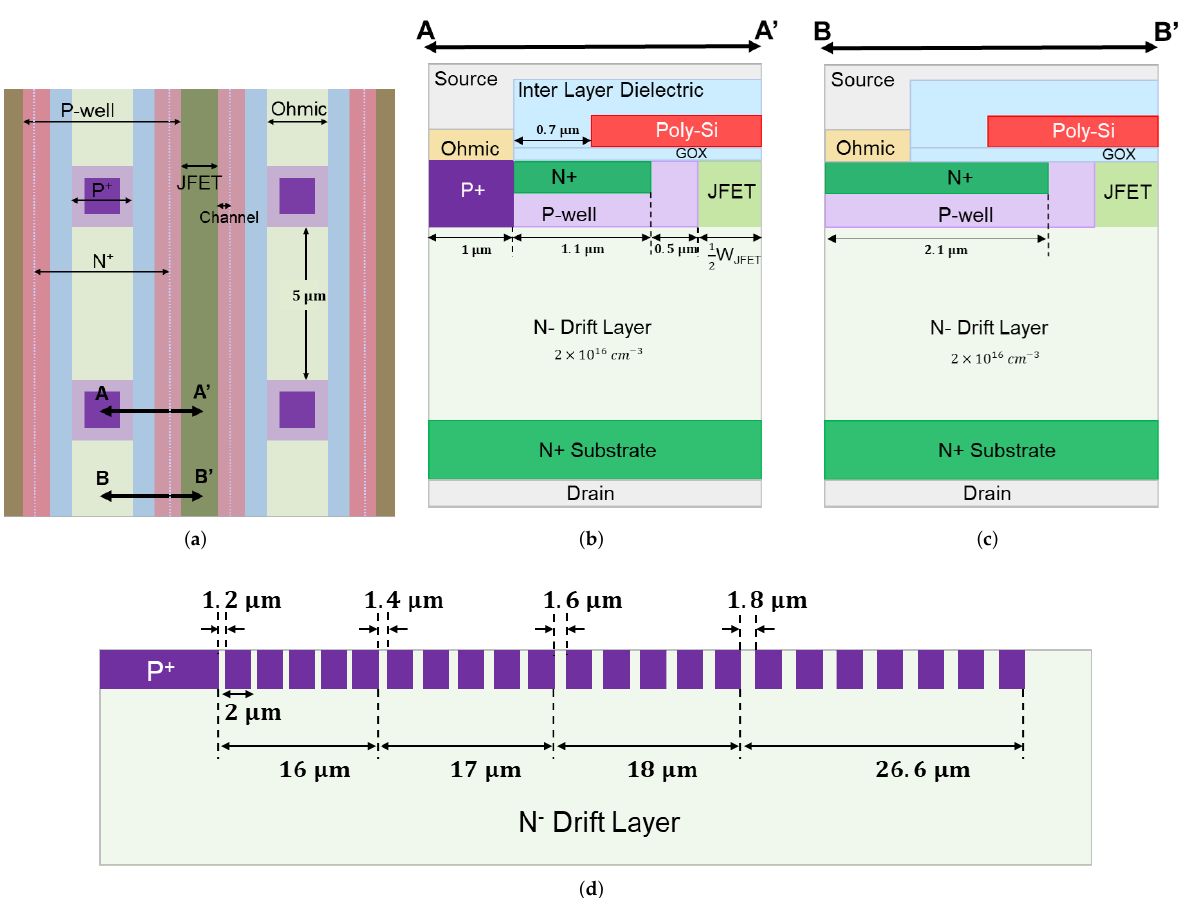
Figure 1. ( a ) Layout design of a SiC power MOSFET with P + located periodically in the center of P-well stripe; ( b ) A-A (cid:48) cross-sectional view showing both P + and N + ; ( c ) B-B (cid:48) cross-sectional view showing extended N + source; ( d ) cross-sectional view of the edge termination of the fabricated 650V SiC power MOSFETs.